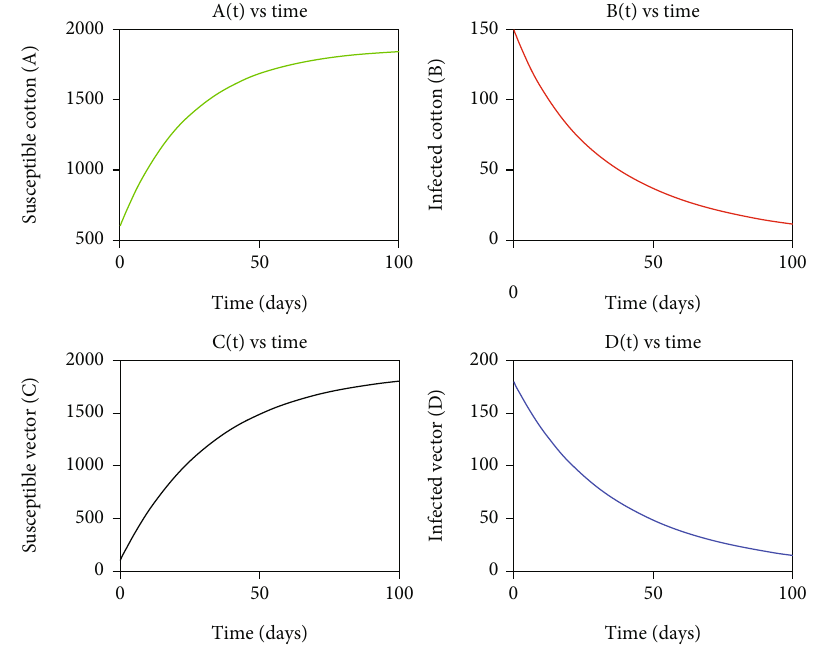
Figure 2: Time series plot of state variables for R